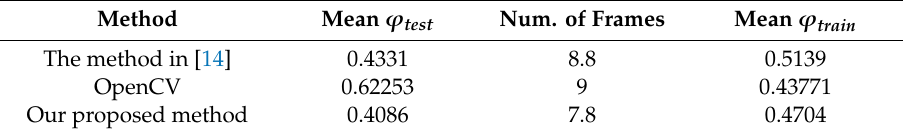
Table 1. Performance comparison of different methods.